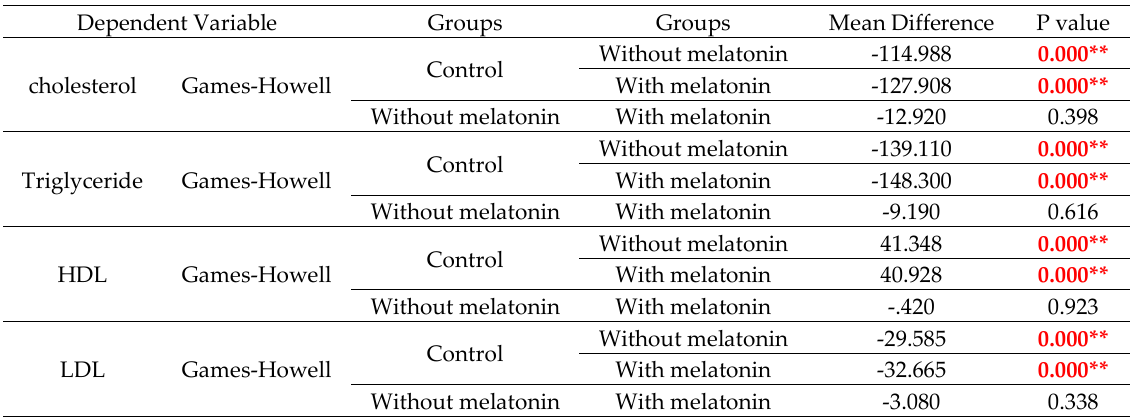
Table 5: Multiple comparisons of lipid profile in the baseline between groups by using Games-Howell